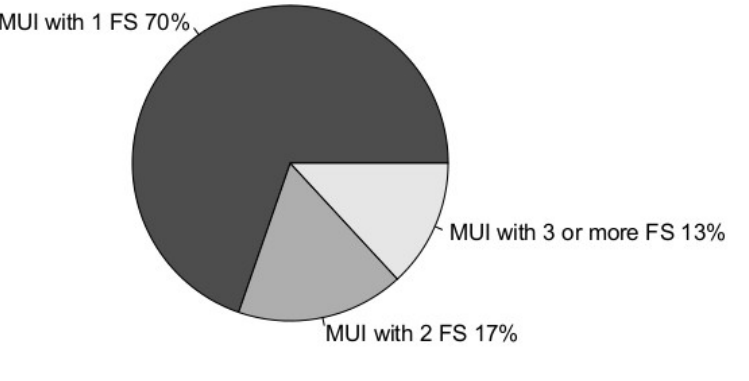
Figure 9. Kind of financial sources supporting museum university partnerships as shown by survey